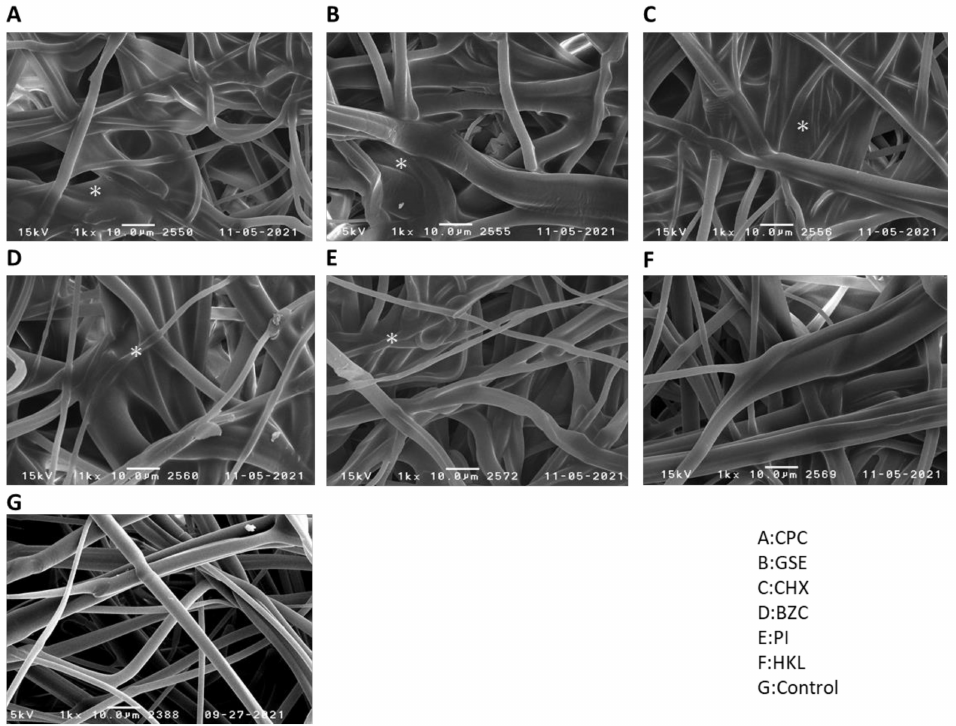
Figure 1. Scanning electron microscopy (SEM) images of the fiber surfaces of non-woven fabric filters treated with CPC ( A ), GSE ( B ), CHX ( C ), BZC ( D ), PI ( E ), or HKL ( F ). Amorphous structures (*) were observed among fibers in certain areas of non-woven fabric filters treated with CPC ( A ), GSE ( B ), CHX ( C ), BZC ( D ), and PI ( E ), but not with HKL ( F ) and ( G )